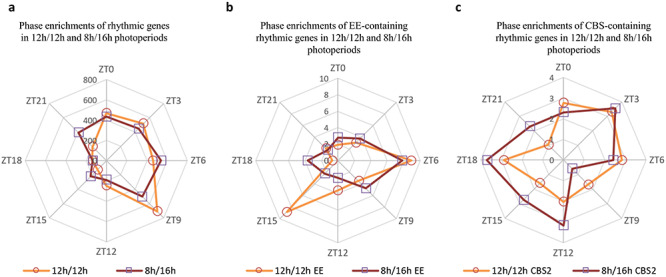
Time-dependent enrichment in core clock elements for both photoperiods: (a) radar chart that represents the number of rhythmic genes with a maximum value of the expression level through photoperiod 12 h/12 h (orange line) and 8 h/16 h (purple line). (b, c) Radar charts that represent the number of rhythmic genes containing cis-regulatory modules (EE and CBS) with the maximum value of the expression level through photoperiod 12 h/12 h (orange line) and 8 h/16 h (purple line).